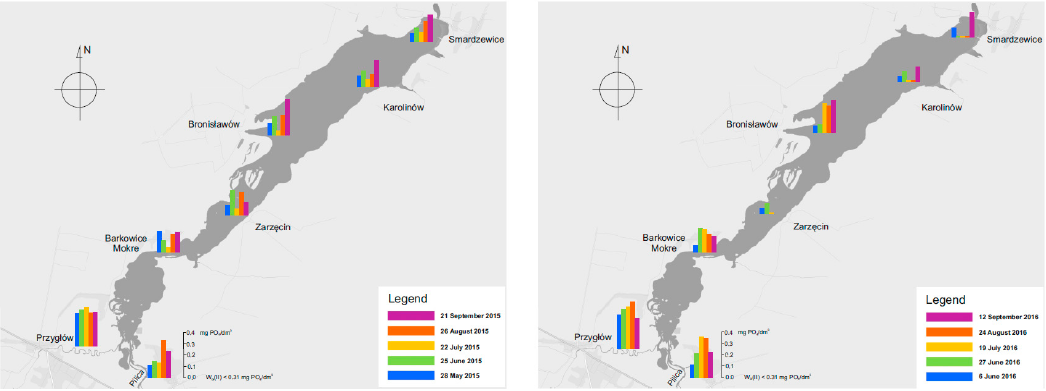
Figure 11. Changes in the concentration of phosphates in the Sulejow Reservoir in 2015 and 2016.